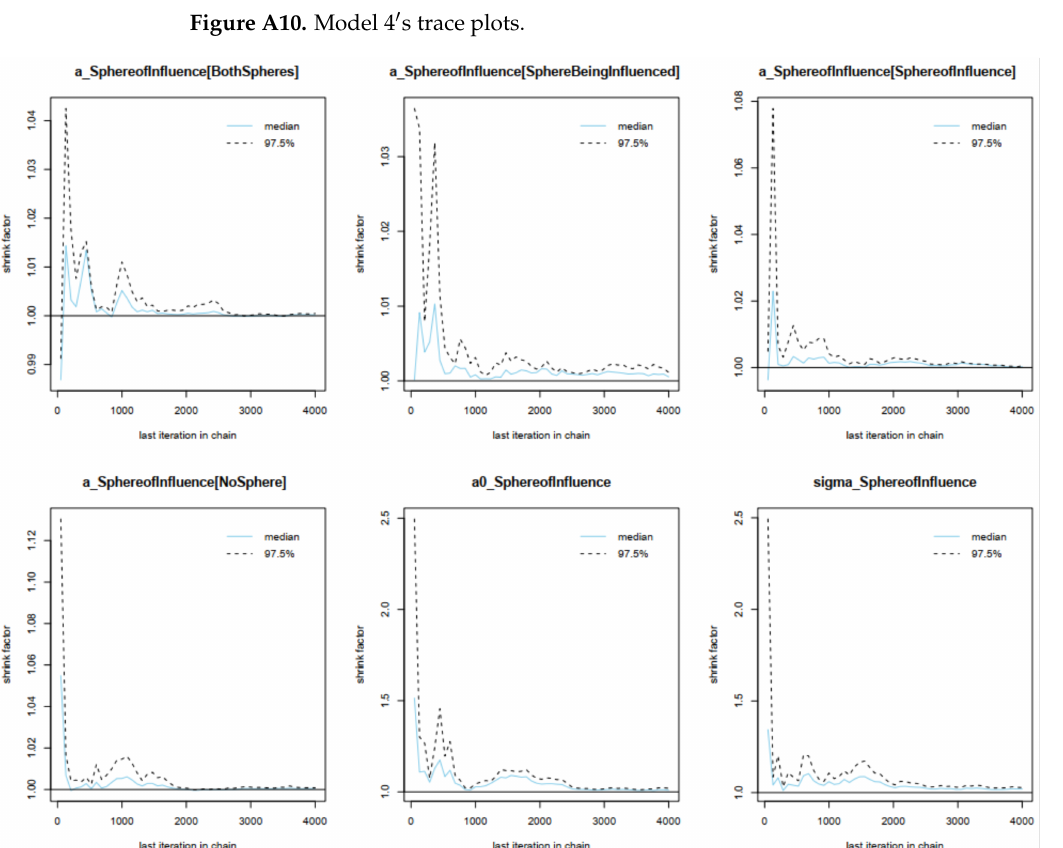
Figure A11. Model 4 (cid:48) s Gelman–Rubin–Brooks